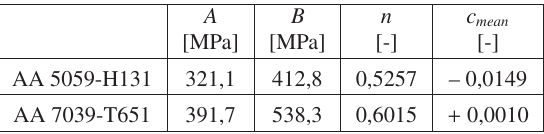
Fig. 12. (a) Sample AA 7039-T651 (#01) @ 0 , 001s − 1 . (b) Sample AA 7039-T651 (#09) @ 30 s − 1 . (c) Sample AA 7039- T651 (#04) @ 1000 s − 1 . Table 3. Johnson-Cook parameters for the analysed